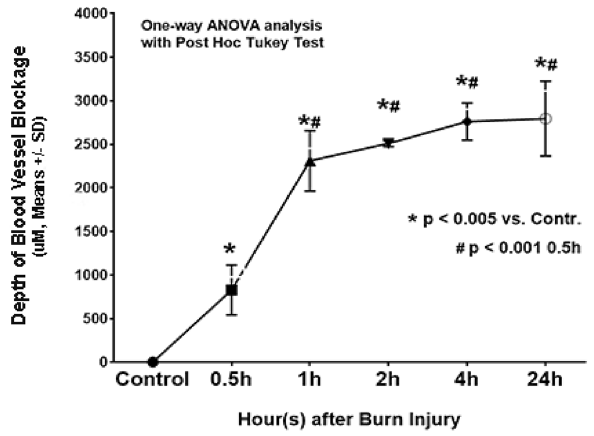
Figure 4. A diagram showing the progression of the depth of blood vessel occlusion measured as the distance from the epidermis to the deepest vertical (from the epidermal basement) location of blood vessel blockage. The measurements were performed on the burn sites of porcine burn wounds harvested at various time points after